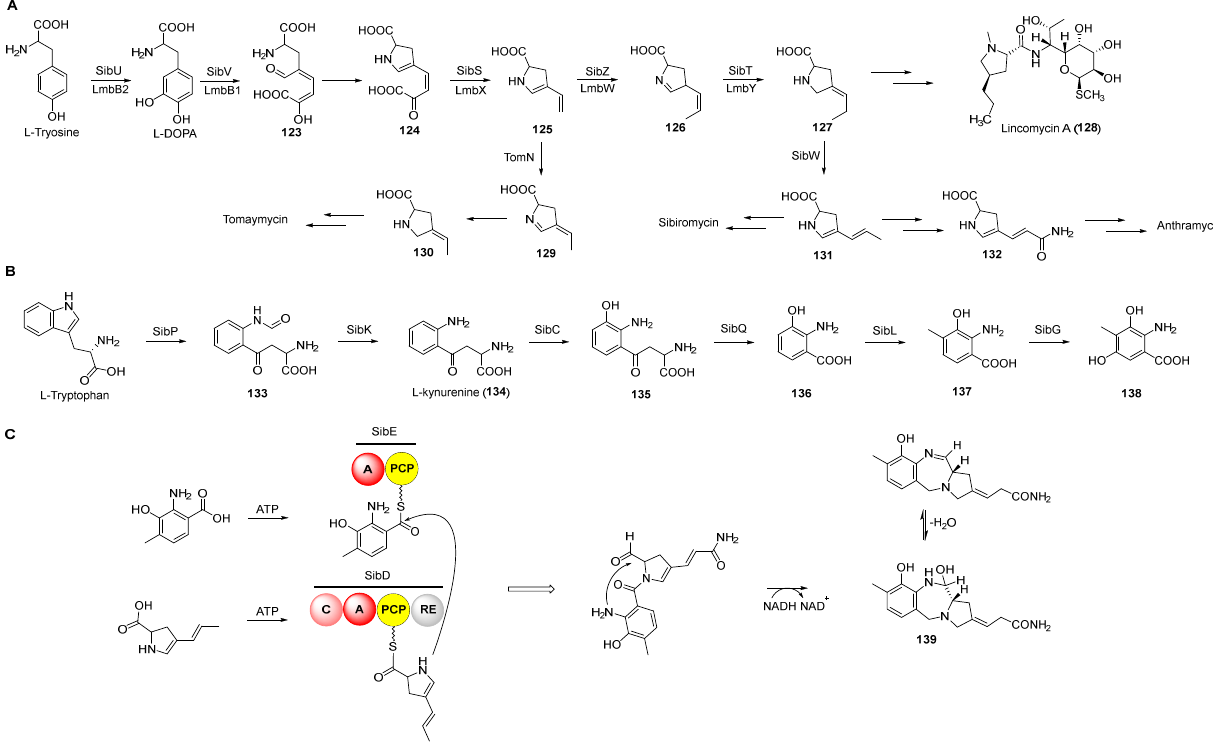
Figure 16. Proposed biosynthetic pathway of dihydropyrrole moieties ( A ), anthranilic acid moieties ( B ), and assembling two building blocks ( C ).